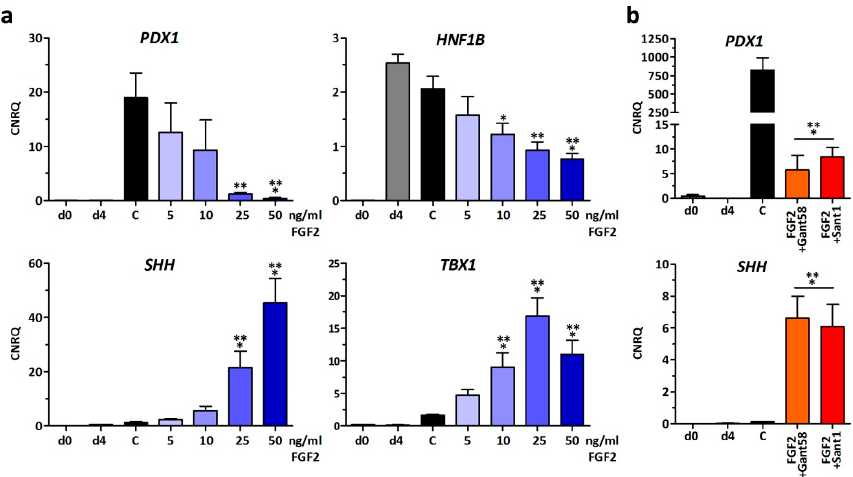
embryonic stem cells (hESC)s at d0, d4, and d8 of differentiation treated ± 5 or 50 ng/mL fibroblast growth factor (FGF)2, FGF7, FGF10, or epidermal growth factor (EGF) in stage 2 medium. Values are means ± SEM, n = 4–6. 5/50 = 5 or 50 ng/mL growth factor, C = control medium without growth factors. ( b ) Fluorescence micrographs after pancreatic differentiation illustrating the protein expression of PDX1/HNF1B after a 4-day treatment ± 5 or 50 ng/mL FGF2, FGF7, FGF10, and EGF. Nuclei were counterstained with DAPI. Scale bar = 200 µm and 20 µm for higher magnification of the control. ( c ) Quantification of cell expansion using ± 50 ng/mL growth factor. Data are presented as mean (log2) ± SEM, n = 3. ( d ) Quantification of PDX1-positive cells upon treatment ± 5 or 50 ng/mL FGF2, FGF7, FGF10, and EGF at d8. Percentages are expressed as means ± SEM. *** = p ≤ 0.001, ** = p ≤ 0.01 compared to control, ANOVA plus Dunnett’s post-test.